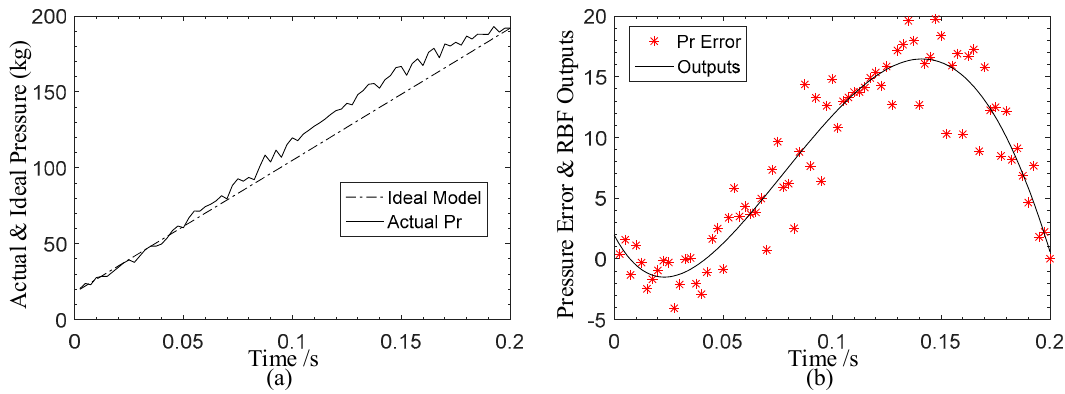
Figure 5. The approximate performance of the RBF neural networks. ( a ) The actual braking pressure value and the ideal one. ( b ) The braking pressure errors and the RBF outputs.